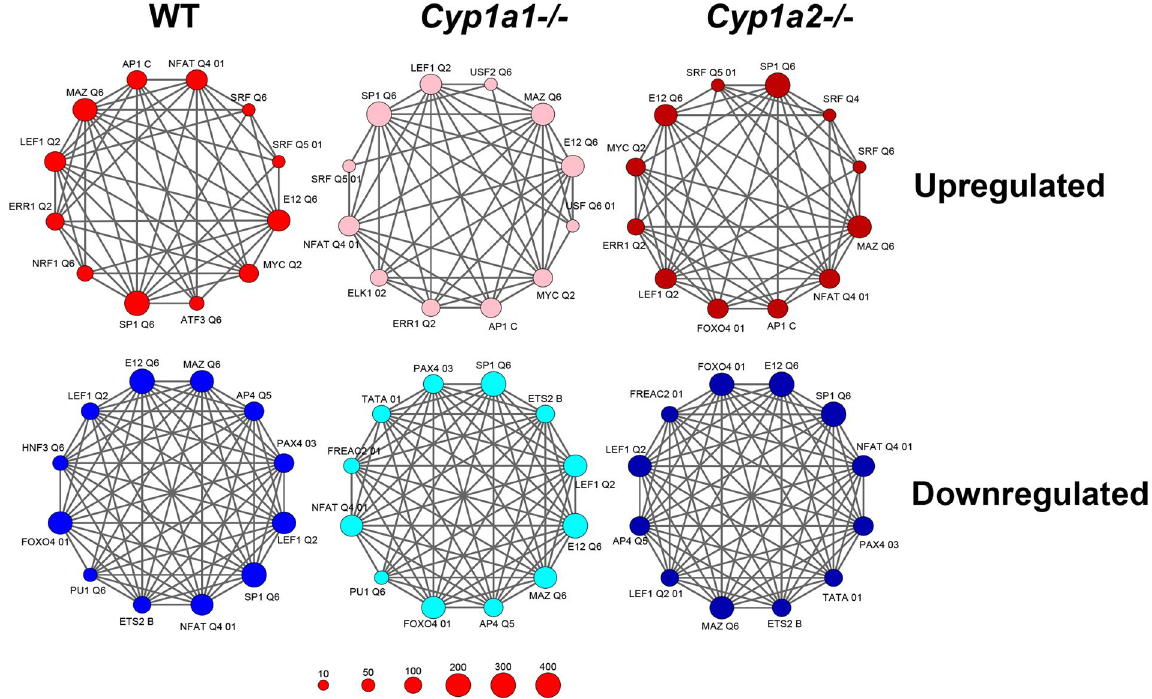
Figure 3. A common network of transcriptional regulators modulates the hyperoxia response. Analysis of upstream transcriptional factors was performed using over-representation analysis (ORA) to identify the key transcription factors modulating the hyperoxia transcriptomic response (hypergeometric distribution; p < 0.05). The top 12 transcriptional regulators in up- and down-regulated genes are depicted as network nodes; edges indicate common gene targets between transcription factors.